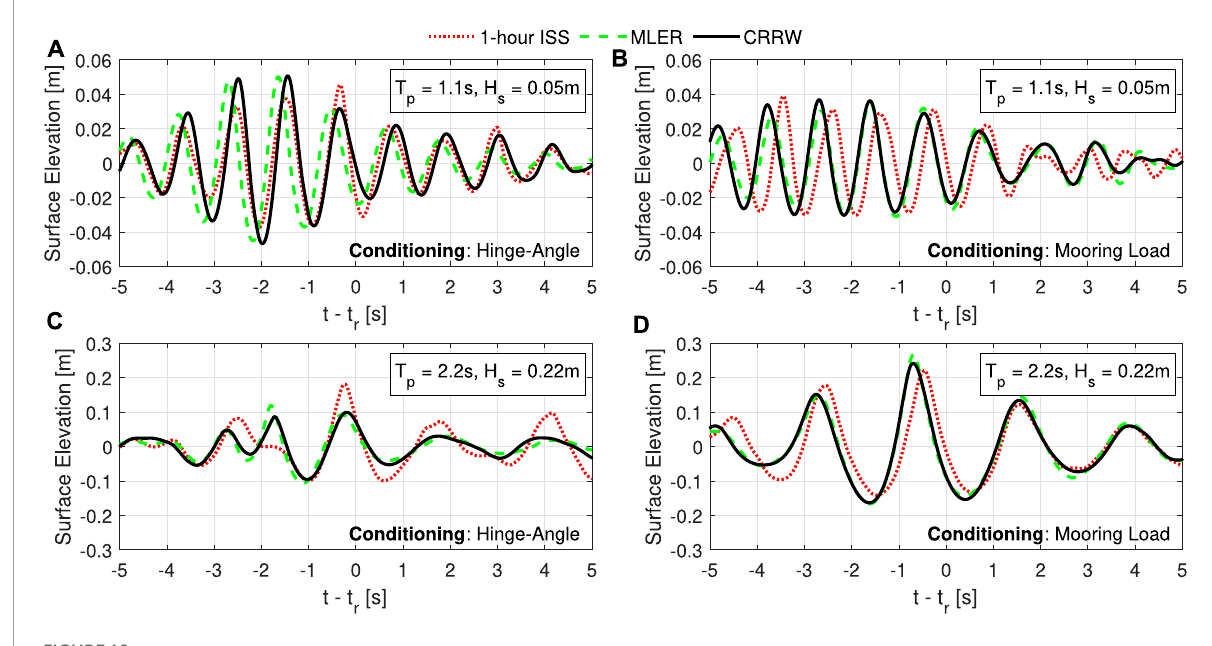
FIGURE 10 Average wave profiles leading to the largest event in each 1-h irregular sea state run (red dotted) compared with the average CRRW (black solid) and MLER (green dashed) wave profiles. Each plot is a different response-conditioning and sea state combination: Hinge-angle in the resonance (A) and 50-year (C) sea states ( γ = 3 . 3 ) ; mooring load in the resonance (B) and 50-year (D) sea states ( γ = 3 . 3 )